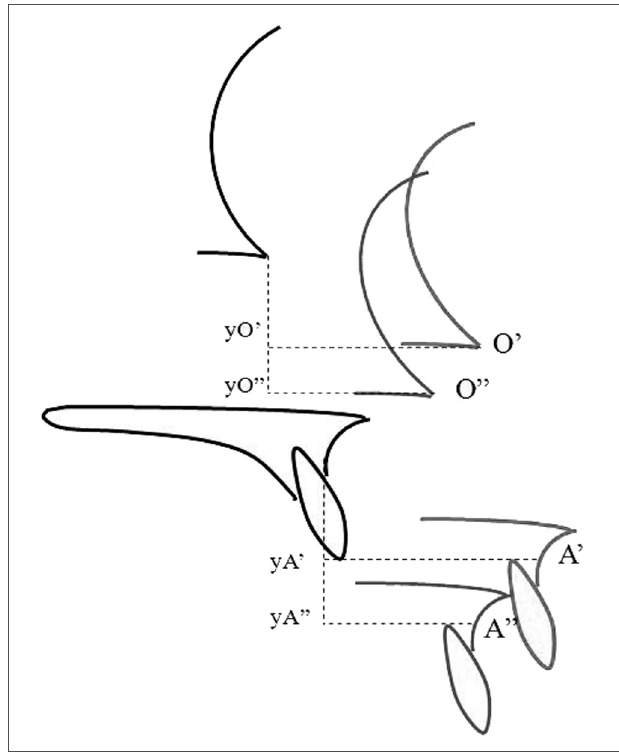
Figure 5. Representation of late vertical repositioning measures: distances measured for reference points between early postoperative tracings (in red) and late postoperative tracings (in blue). A’: point A on the early postoperative tracing; yA’: projection of point A’ on the vertical axis drawn from point A; A”: point A on the late postoperative tracing; yA”: projection of point A” on the vertical axis drawn from point A on the late postoperative tracing; O’: point O no early postoperative tracing; yO’: projection of point O’ on the vertical axis drawn from point O; O”: point O no late postoperative tracing; yO”: projection of point O” on the vertical axis drawn from point O on the late postoperative tracing. Distance yA’-yA”: amount of late vertical repositioning for point A. Distance yO’-yO”: amount of late vertical repositioning for point O.